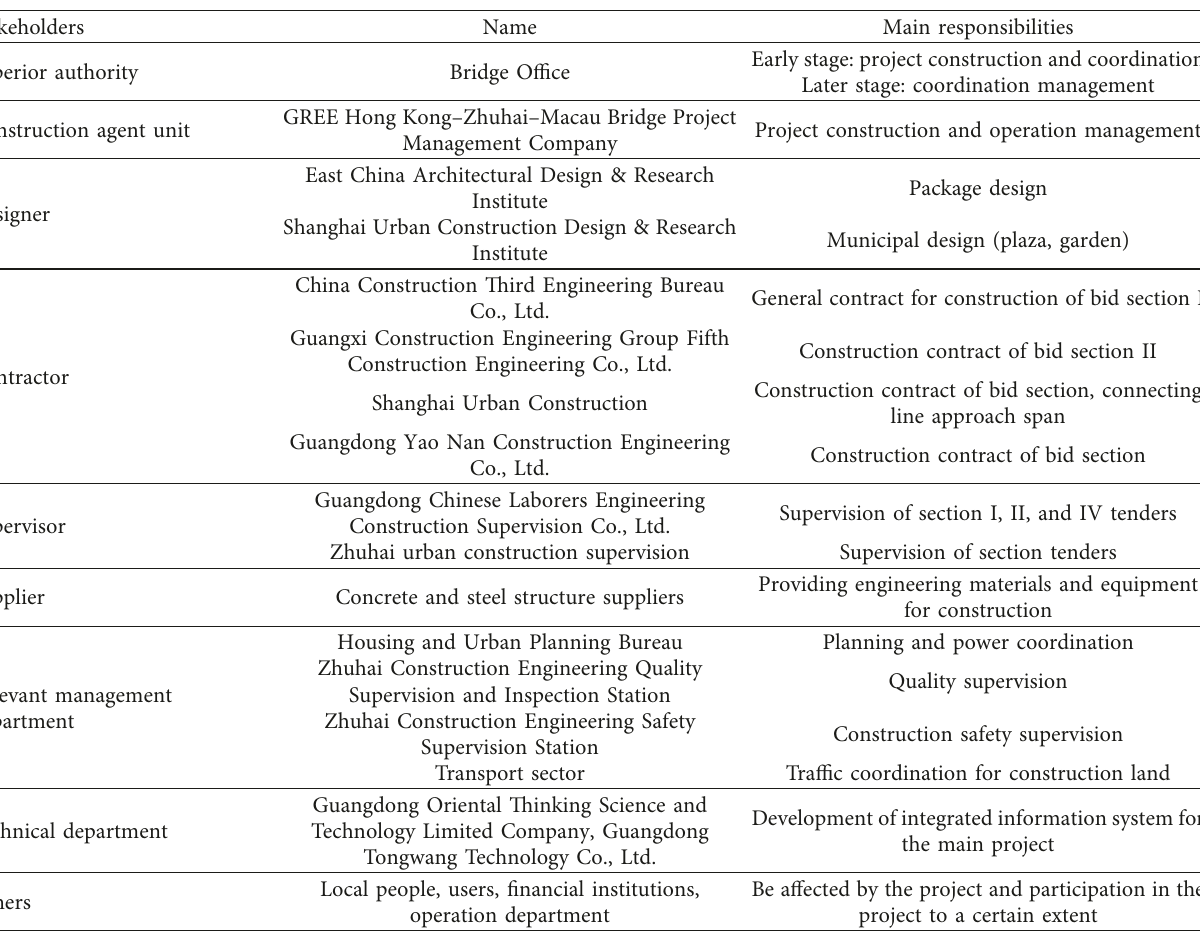
Table 1: Project